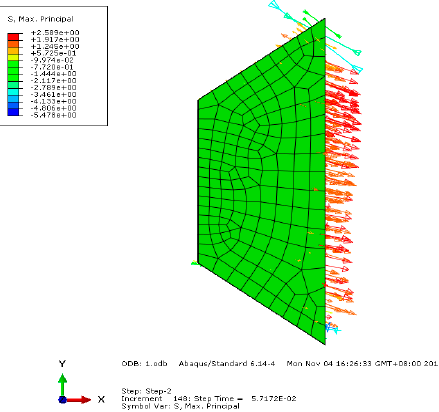
Figure 16. Distribution of the maximum principal tensile stress on the key root section.